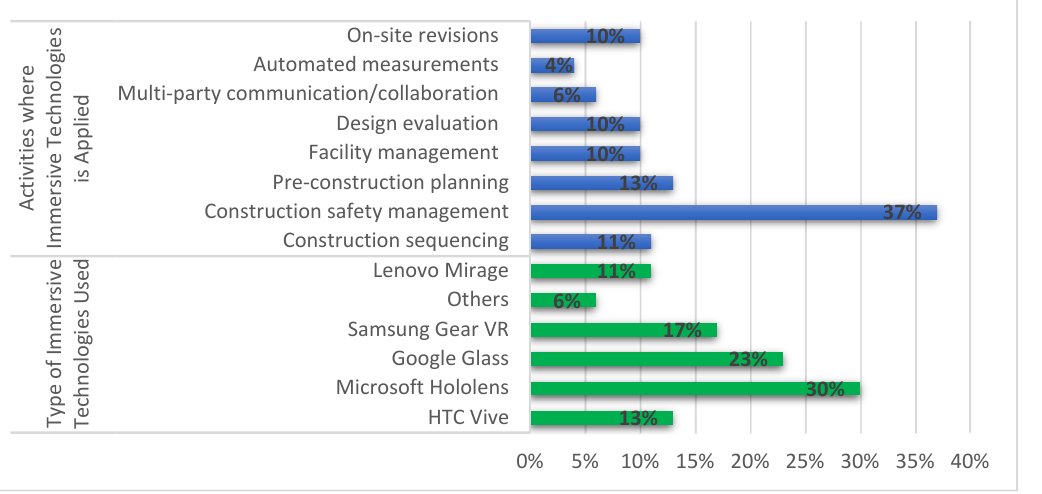
Figure 3. Type of immersive reality technologies (ImTs) used and the activities for which they are used ( n = 67).